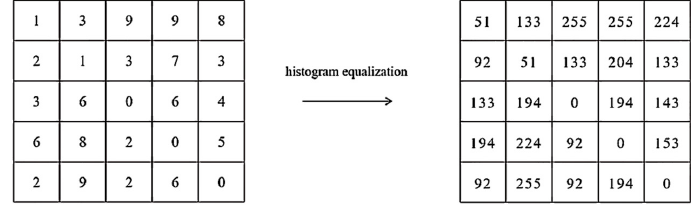
Figure 5. Histogram equalization of pixels .